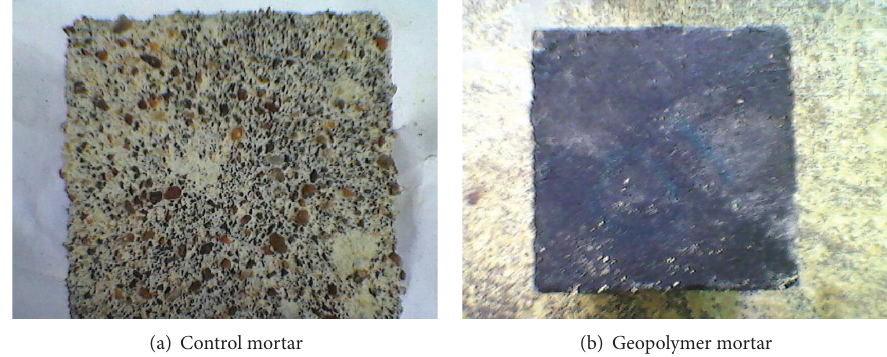
Figure 11: Photograph of specimen immersed in 5% H 2 SO 4 .